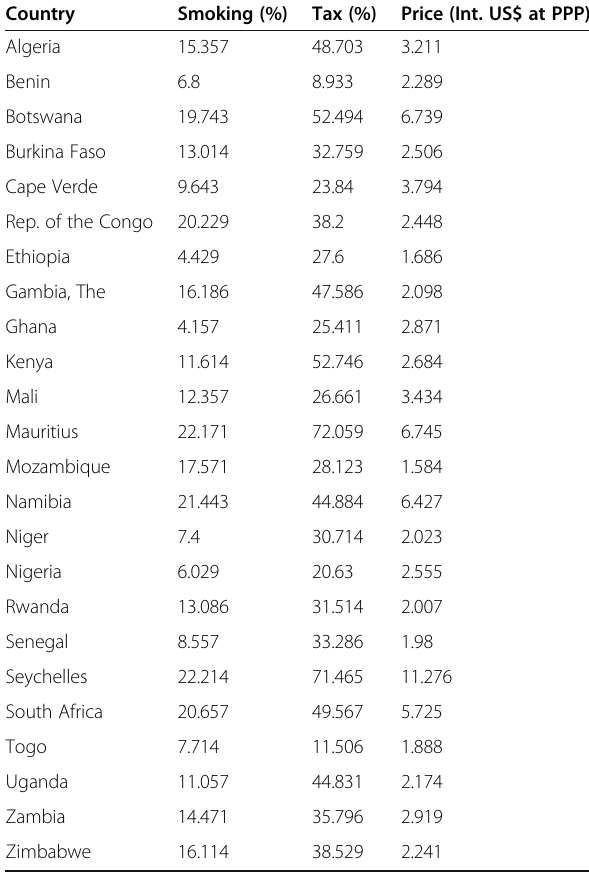
Table 1 Mean smoking prevalence, tobacco taxation and pricing per country (2010 –